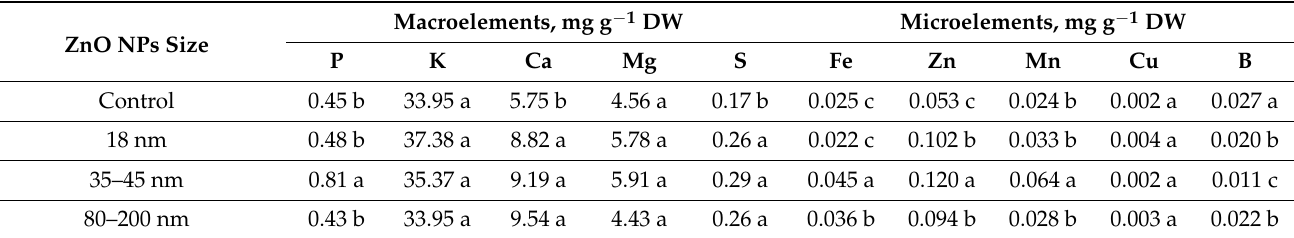
Table 3. Particle size-dependent effects of ZnO nanoparticles on the macro- and micronutrients of Swiss chard, mg g − 1 DW. Different letters represent significant differences. The data were pro- cessed using analysis of variance (ANOVA) according to the Tukey (HSD) multiple range test at the confidence level of p = 0.05.